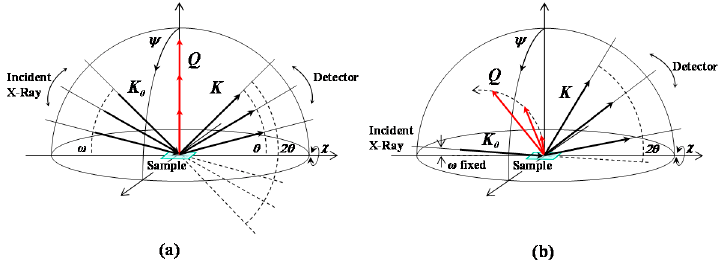
Figure A1. Schematic diagrams of out-of-plane ( a ) θ /2 θ XRD and ( b ) grazing-incidence XRD geometries.